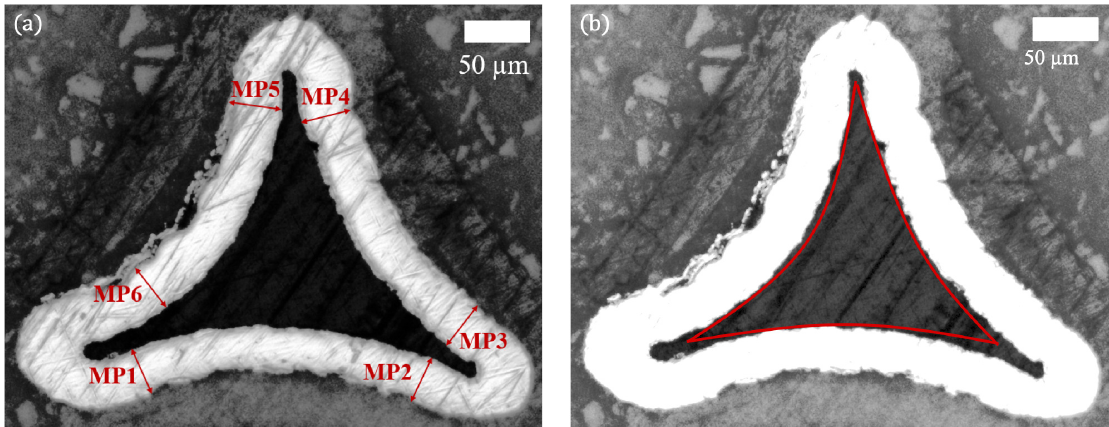
Figure 3. ( a ) micro-section of a strut with highlighted positions of coating thickness measurement (MP1-MP6); ( b ) edited micro-section showing the size estimation of PU